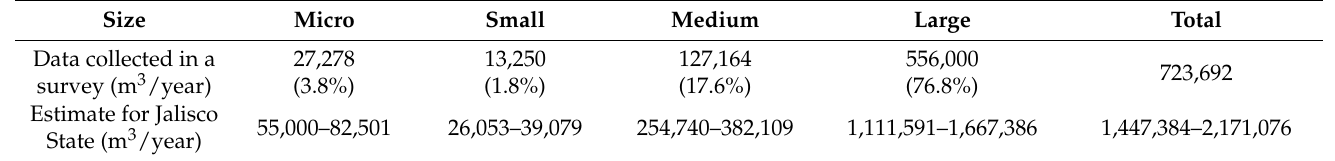
Table 4. Tequila vinasses generated in Jalisco state (collected and estimated